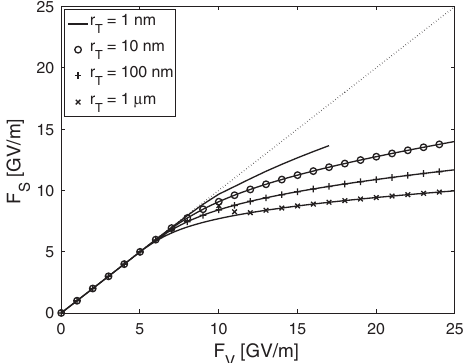
FIG. 3. Comparison of Fowler-Nordheim and general thermal- field current densities for copper work function taken as (cid:1) ¼ 4 : 5 eV .